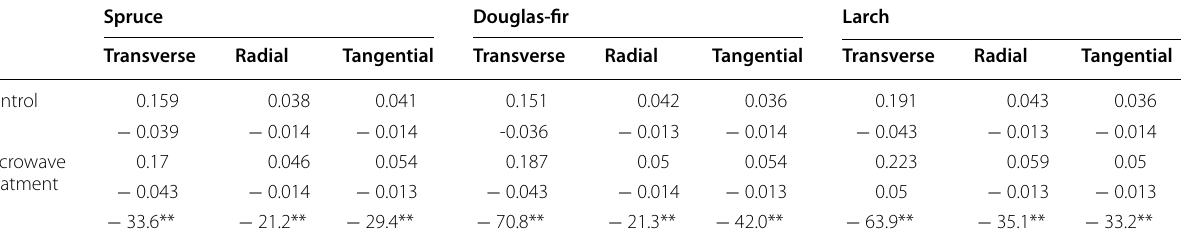
Table 1 Average sound absorption coefficient of three softwood species at 2000–5000 Hz before and after microwave treatment depending on anatomical